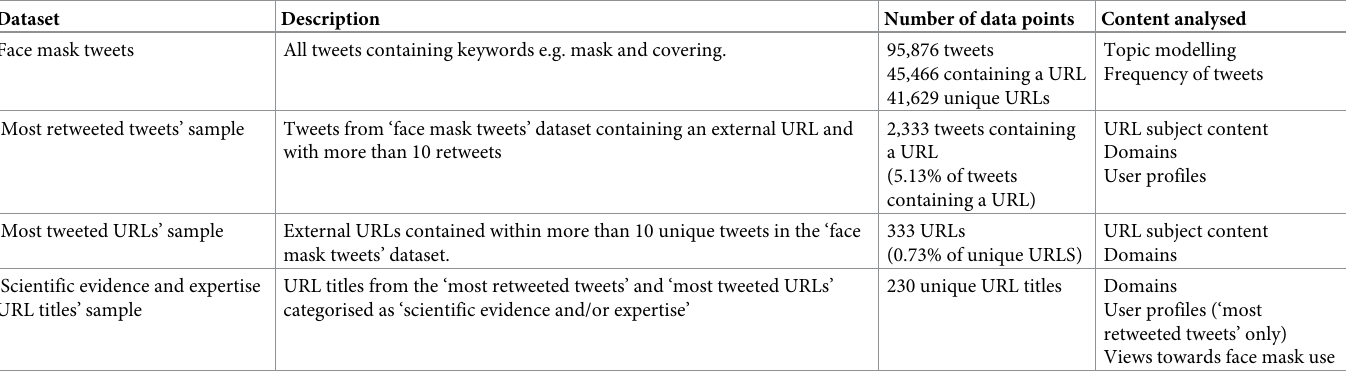
Table 2. Twitter datasets and content analysed. Dataset